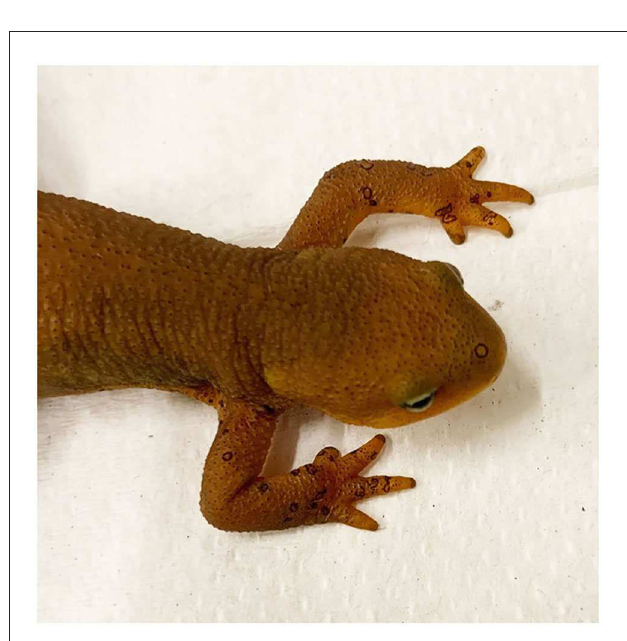
duplicates = 0.28) and with a known human control sample. Gels were scanned and analyzed using software provided by